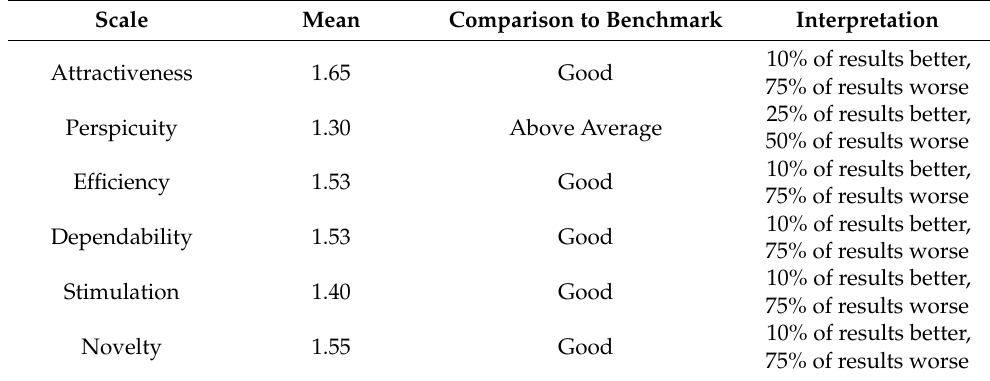
Table 6. Comparison to